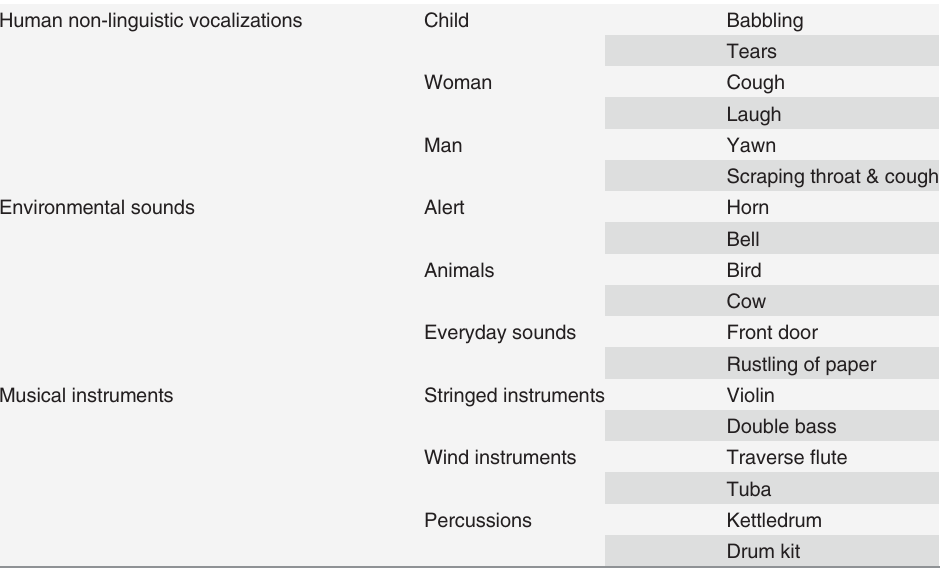
Table 2. Stimuli included in the FST grouped in a priori